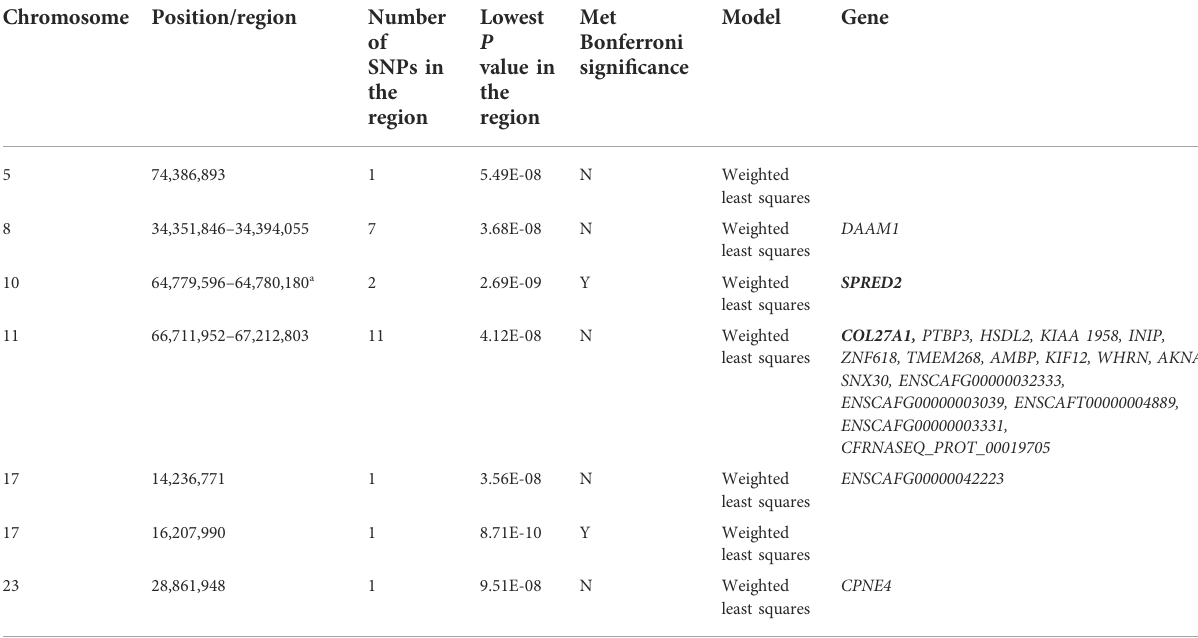
(Figure 3). The region on chromosome 10 (Table 5) is a known HD associated locus and contained SPRED2 (Todhunter et al., 2005). Of the SNPs that were approaching genome-wide signi fi cance, a chromosome 11 region contained COL27A1 and was reported as signi fi cant with the LMM GWAS. 20 SNPs located on chromosomes 1, 14, 16, 17, 19, 22, and 30, met genome- wide signi fi cance for the weighted least squares analysis of the ACL rupture dataset (Table 6). The signi fi cant locus on chromosome 14 was also reported as signi fi cant with the LMM GWAS. The chromosome 17 locus at 44,167,247 – 44,171,925bp was also reported as signi fi cant with the LMM and haplotype GWAS, and this region also overlapped with a hospital HD candidate locus. The SNP effect estimates are reported in Supplementary Data